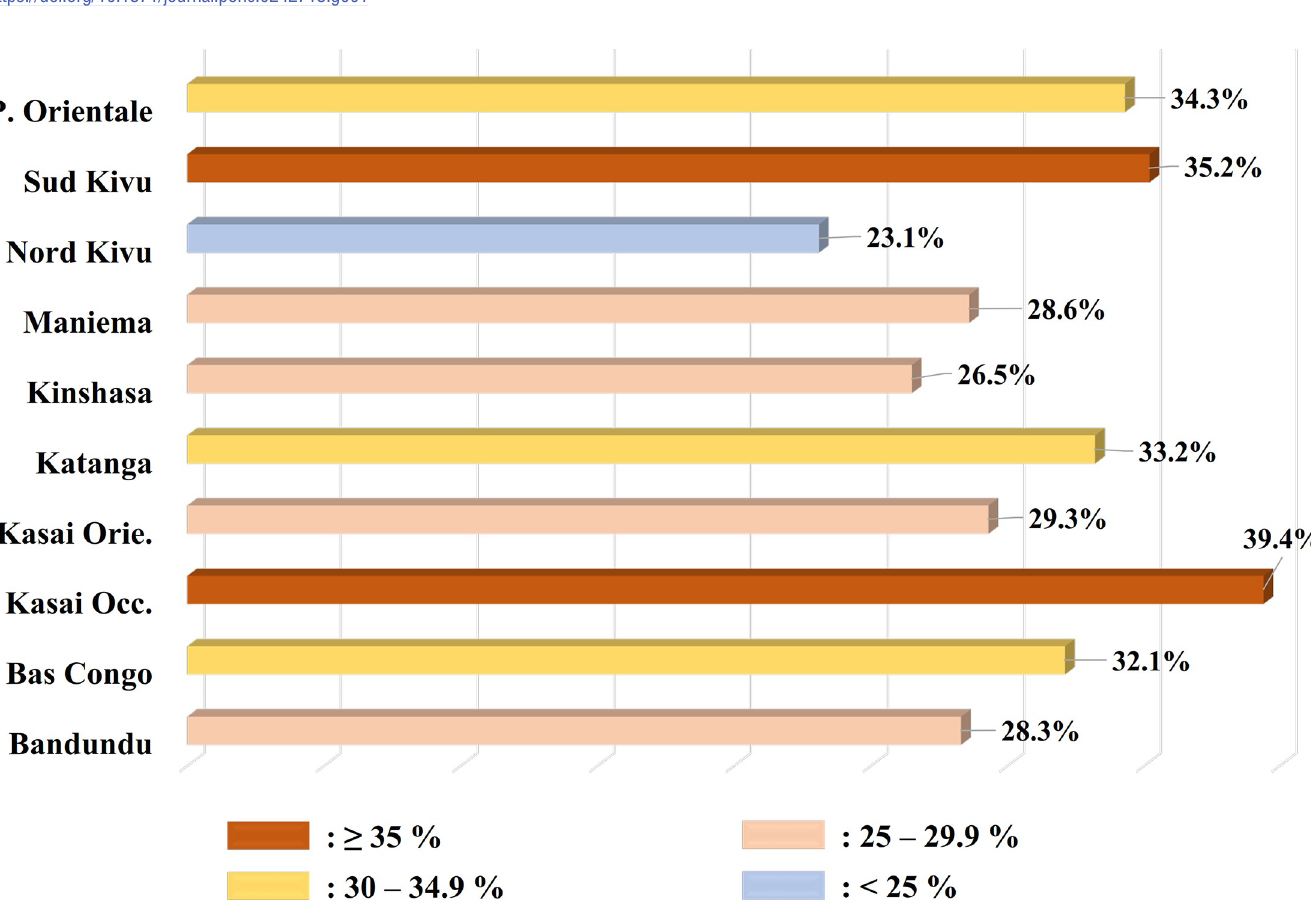
PLOS ONE | https://doi.org/10.1371/journal.pone.0242713 November23, 2020 7 /